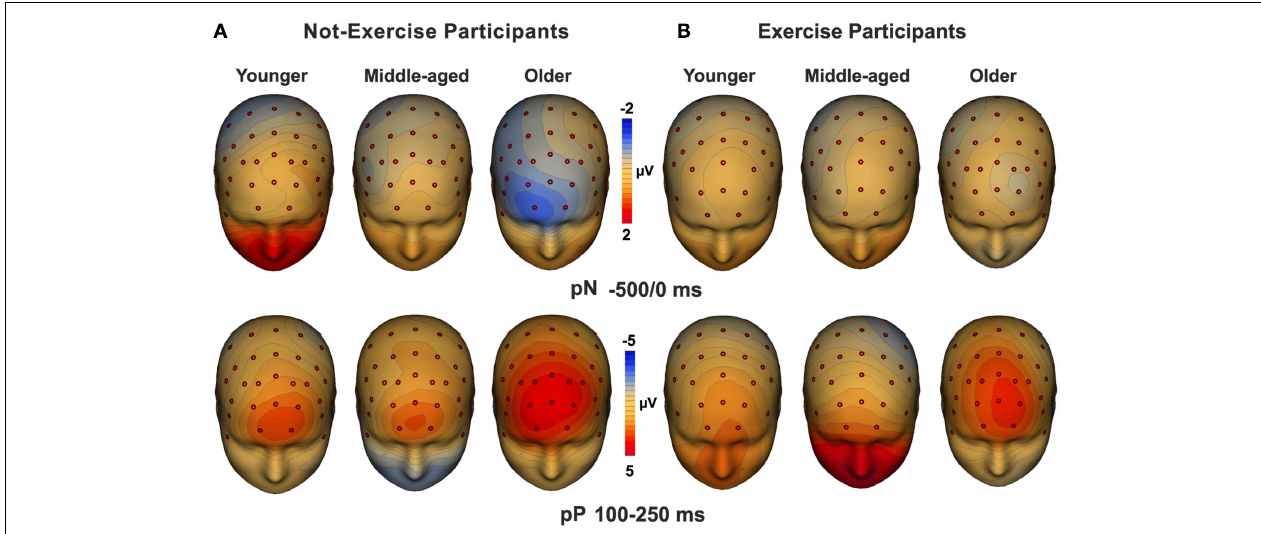
FIGURE 3 |Topographical maps of the pN (up) and pP (bottom) components .The maps for young, middle-aged, and older adults are displayed from the left to the right for not-exercise (A) and exercise (B)